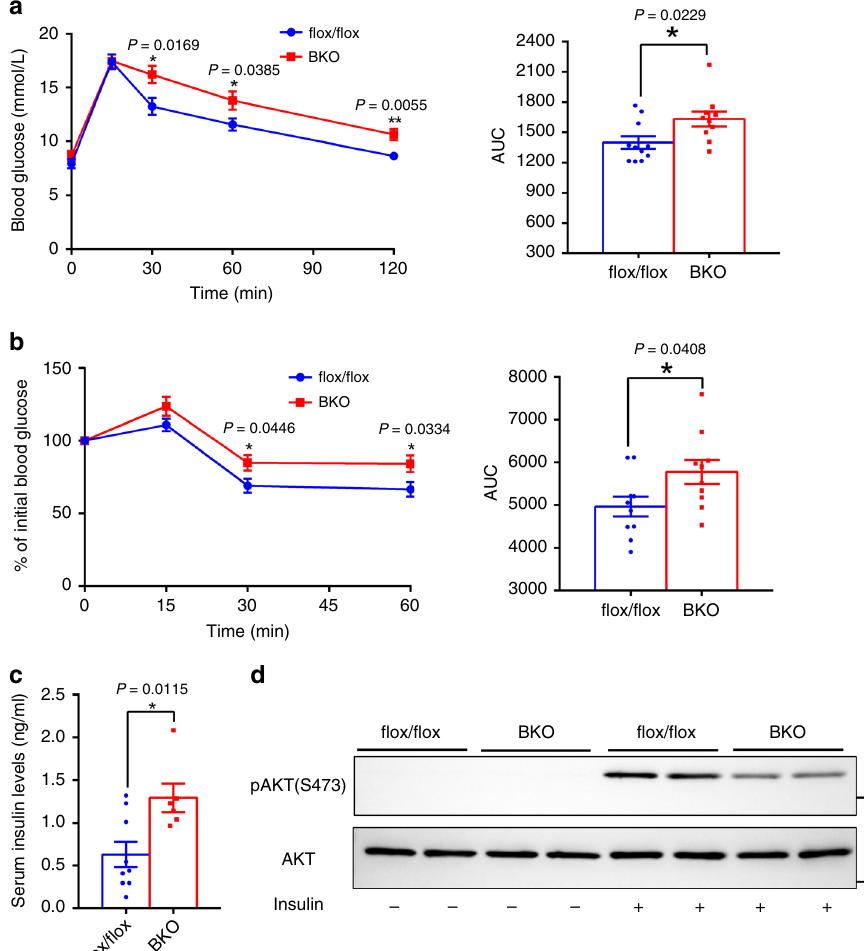
Fig. 9 BAT-speci fi c knockout of Mettl3 predisposes to HFD-induced glucose intolerance and insulin resistance. a GTTs of 16-week-old HFD-fed mice ( Mettl3 fl ox/ fl ox , n = 11; BKO, n = 10). b ITTs of 16-week-old HFD-fed mice ( n = 10 for each group). c The serum insulin levels of 20-week-old HFD-fed mice ( Mettl3 fl ox/ fl ox , n = 9; BKO, n = 6). d p-AKT(S473) and AKT protein levels of 20-week-old HFD-fed mice. This experiment was repeated three times by using three different groups of mouse samples with similar results. Data represent the mean±SEM. Signi fi cance was determined by unpaired two-tailed Student ’ s t test analysis. * p < 0.05. Source data are provided as a Source Data fi